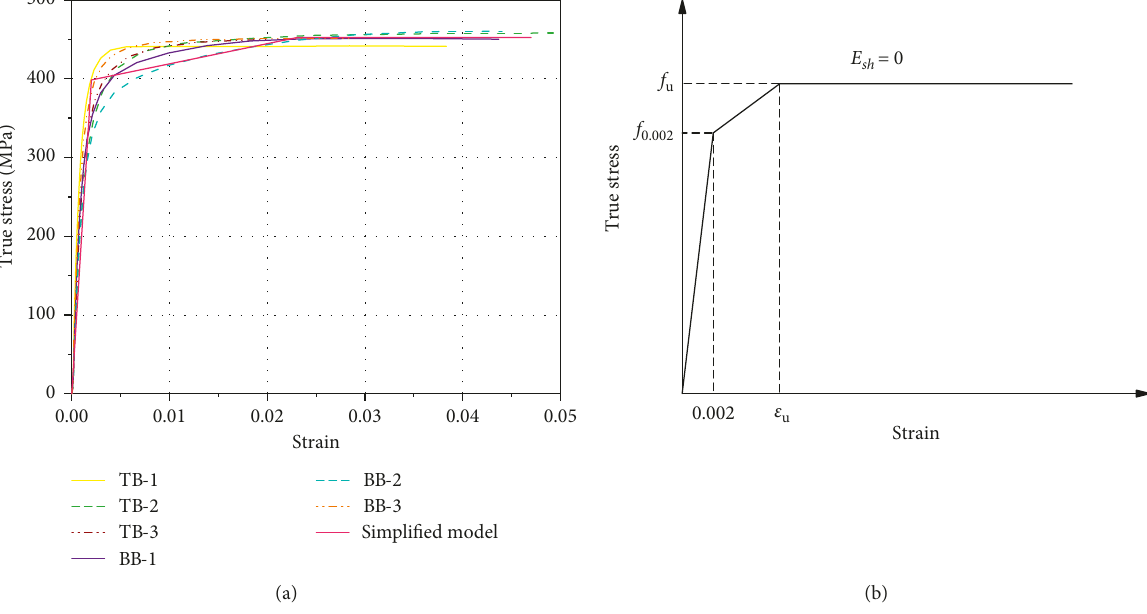
Figure 15: Simplified model of true stress-strain curve of the corner region: (a) features of true stress-strain curves of the corner region; (b) trilinear constitutive model for the corner region.